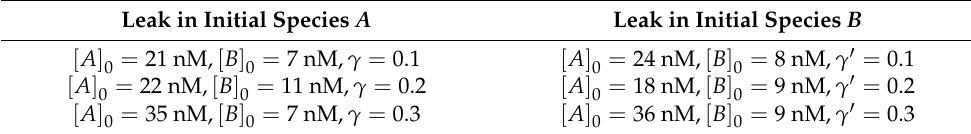
Table 8. Two cases of initial species concentrations and leak parameters γ and γ (cid:48) .